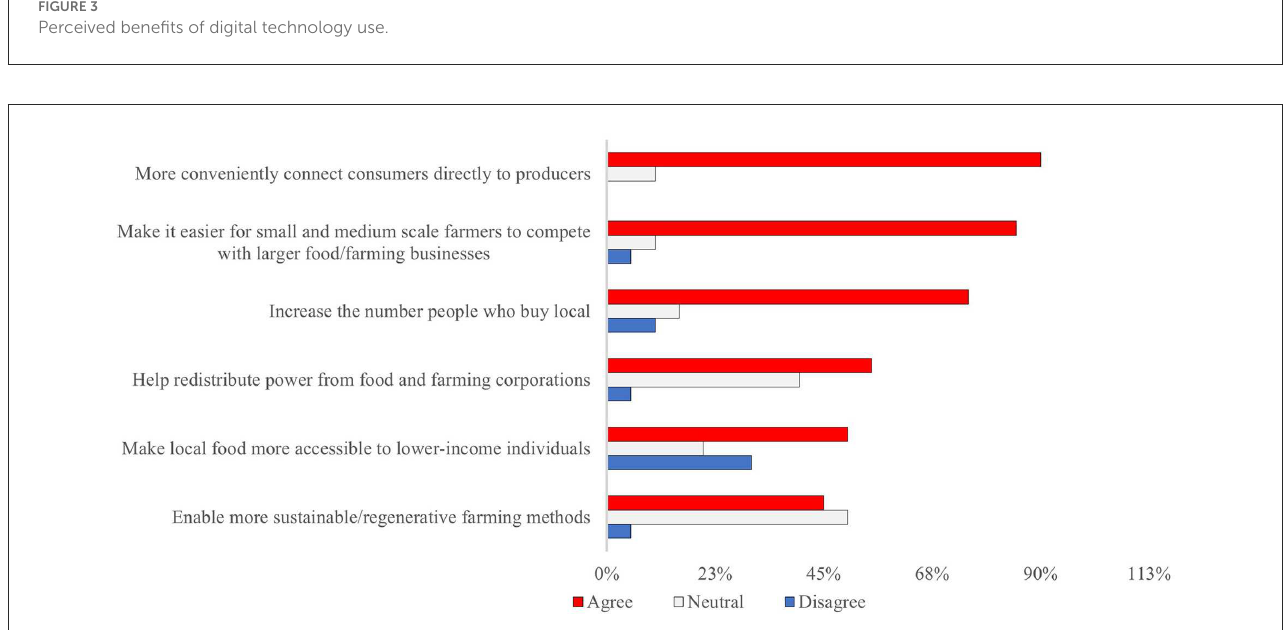
FIGURE4 Perceptions of broader impacts of digital tools in local food sector.